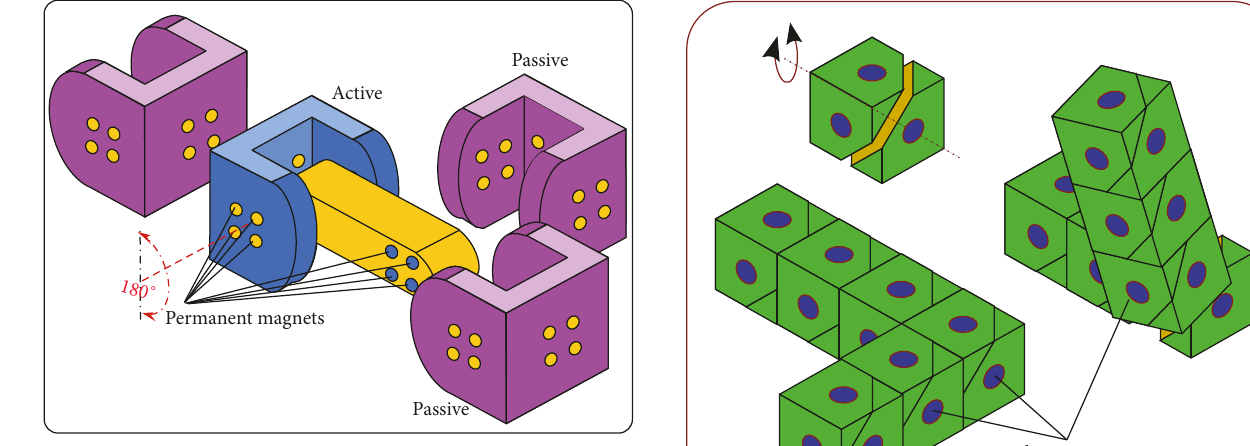
Figure 13: Model diagram of M-Tran MSRR.